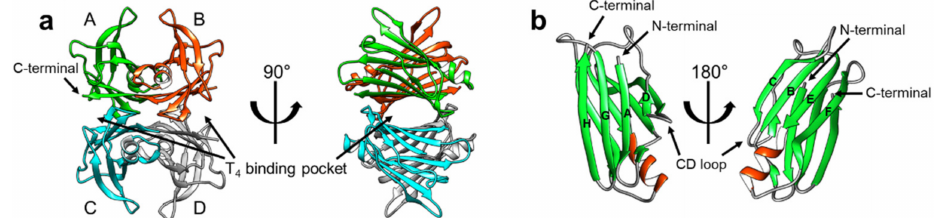
Figure 1. The X-ray crystallographic structural model of transthyretin (TTR) in its native-like (tetrameric) state (PDB 2QGB). ( a ) The tetrameric structure of TTR has been shown in two ori- entations, with the T 4 -binding pockets marked with arrows. The monomeric subunits are denoted by ‘A’ through ‘D’ and colored differently for better visualization. Note that the TTR tetramer has two dimeric interfaces; the interface between AC and BD is maintained by an extensive network of hydrogen bonds, whereas the interface between AB and CD is mainly constituted by hydrophobic interactions. ( b ) The monomeric subunit of the tetrameric complex ( a ) is displayed from two different orientations to show its secondary and tertiary configurations. Note that the eight β -strands are marked by ‘A’ through ‘H’ according to their sequential order from the N-terminal, showing the DAGH and CBEF β